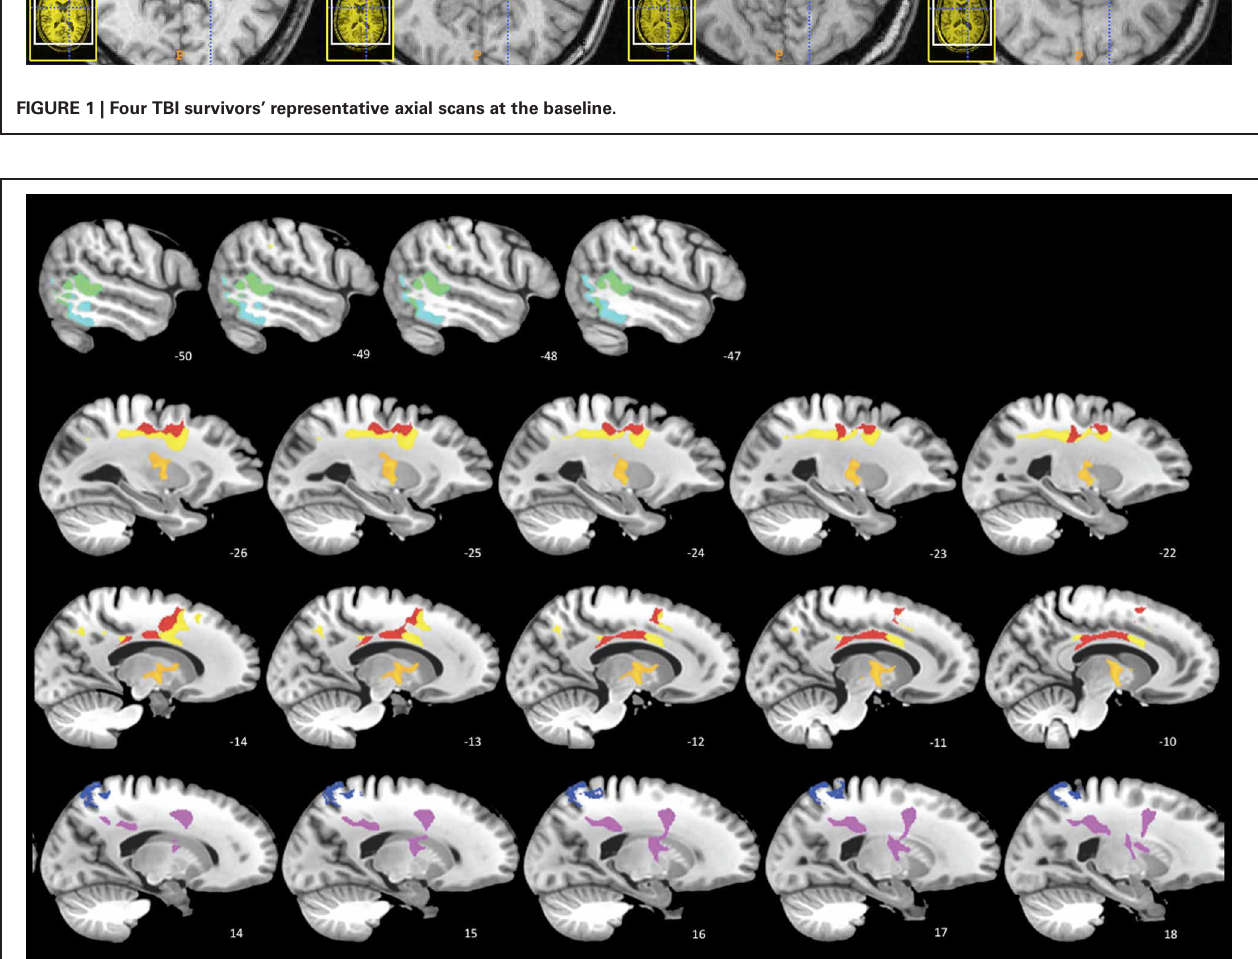
FIGURE 2 | SCCAN reveals multiple cortical and white matter regions of longitudinal atrophy. Cortical areas (cool colors) include posterior temporal lobes, posterior cingulate, and superior parietal lobe. The white matter and